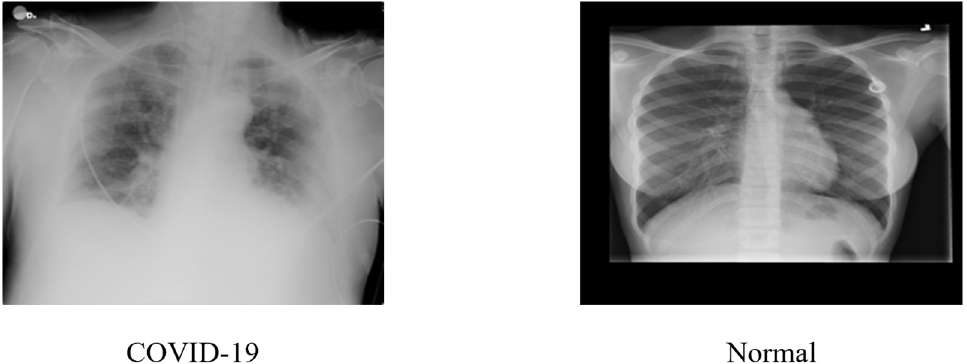
Figure 3. CXR images of the COVID-19 and healthy patient.